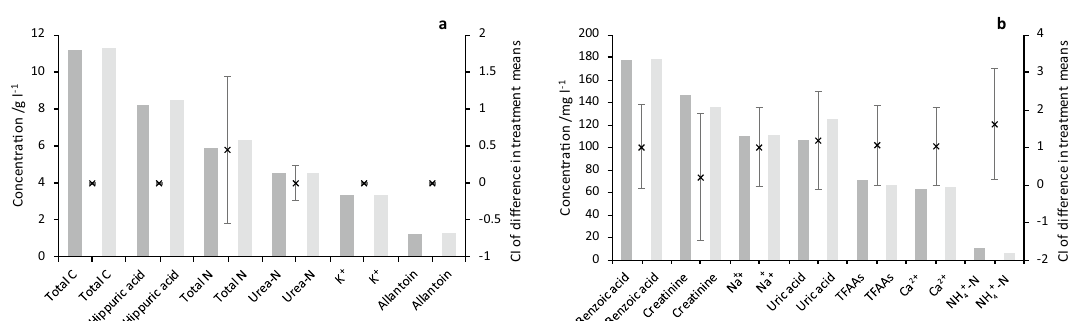
Figure 1. Urine N concentrations of unfiltered ( a – c ) and filtered ( d – f ) samples stored at room temperature ( a and d ), in a refrigerator (8 °C; b and e ) or in a freezer (-20 °C; c and f ) for up to 49 days. Error bars are ± standard errors of the means (SEMs; n = 3), average confidence intervals (CIs) for the full fixed model (filtering*temperature*time) were as follows: total N mean ± 0.170; NH 4 + -N mean ± 1.05; NO 3 – N mean ± 1.28; total organic N mean ± 0.192.